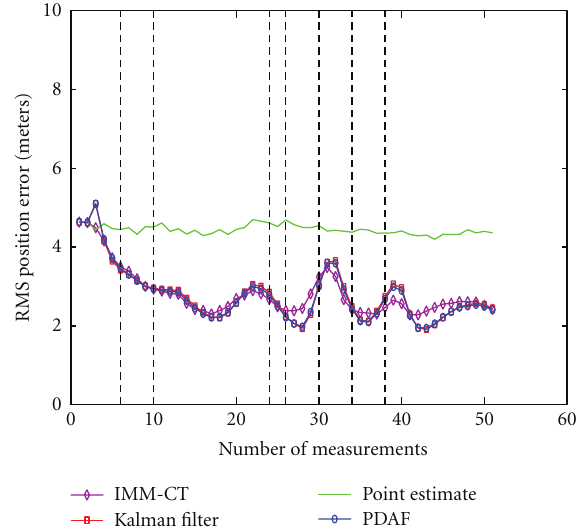
Figure 8: Root-mean-squared (RMS) localization error as a function of the number of measurements acquired as the receiver moved in the scenario.